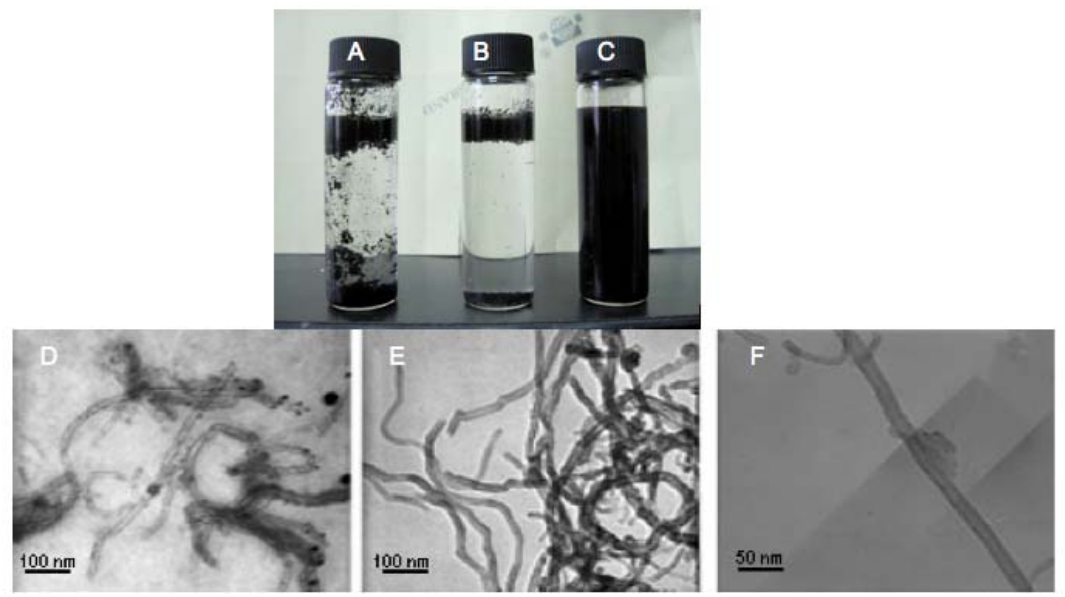
Figure 7. Photographs of ( A ) pristine MWNTs; ( B ) MWNTs-alk and ( C ) MWNTs-PNIPAM-1 in water; ( D ) TEM images of pristine MWNTs; ( E ) MWNTs-alk; ( F )